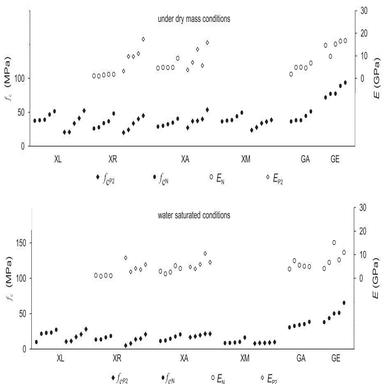
Individual compressive strength fc and static elastic modulus E results under dry mass (above) and saturated conditions (bellow).